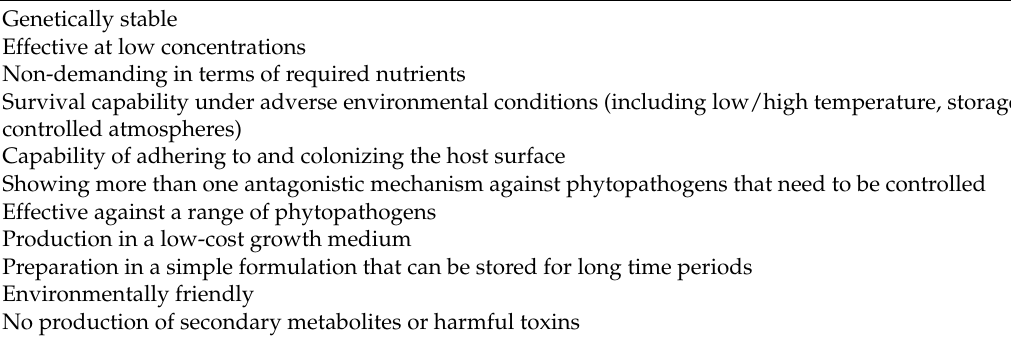
Table 2. Ideal characteristics of a biological control agent [29].